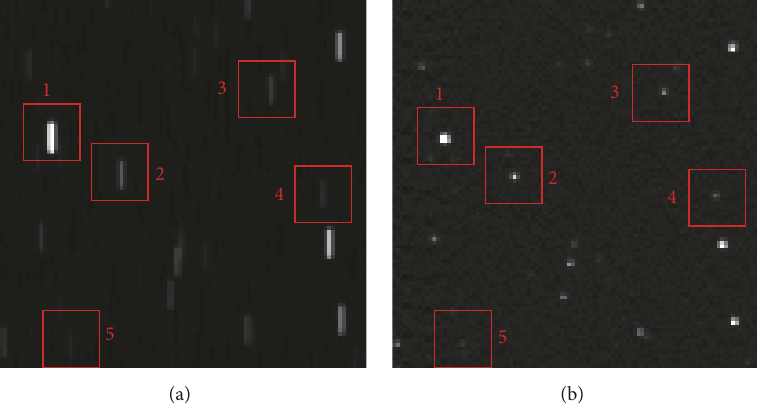
Figure 8: Experimental result when zenith angle is 75 ∘ . (a) The original stars image. (b) The corrected image of